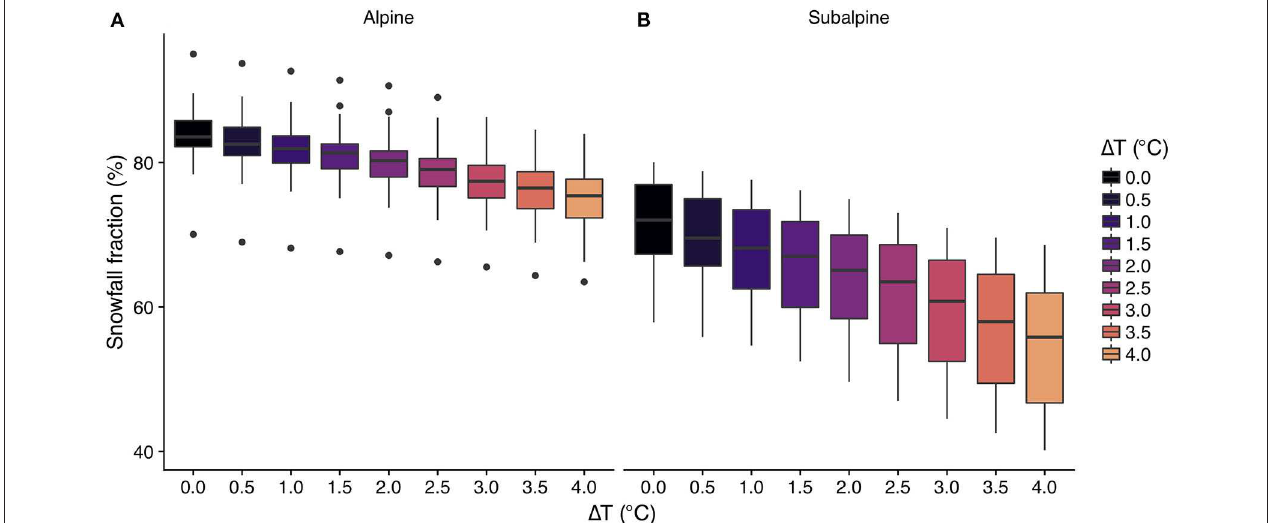
FIGURE 3 | Annual snowfall fraction for the baseline and 1 T perturbations in the alpine (A) and subalpine (B) for the 23 simulation years. Boxplots show the median, interquartile range, and outliers for the annual snowfall fraction.